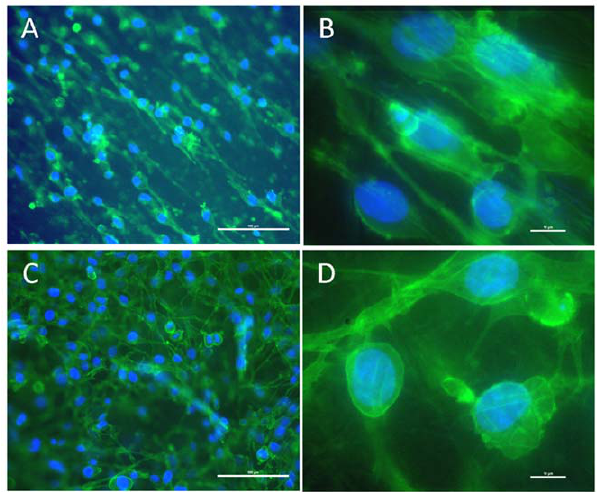
Figure 7. Immunostaining identification of adult rat SCs by p75LNGFR and counterstained by DAPI. Cells on aligned (A and B) and random nanofibers (C and D) showed p75LNGFR positive staining after 7 days of culture. Scale bars show 20 6 (100 m m) for A and C, and 100 6 (10 m m) for B and D pictures.